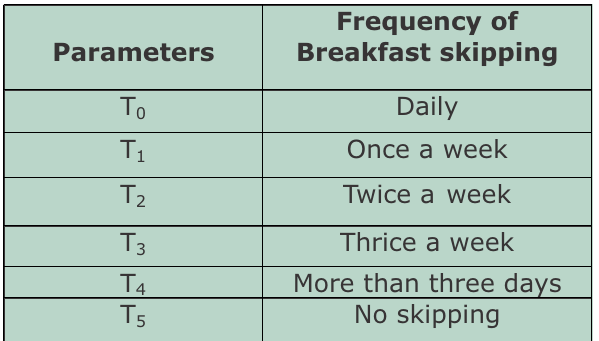
Table-I: Breakfast skipping